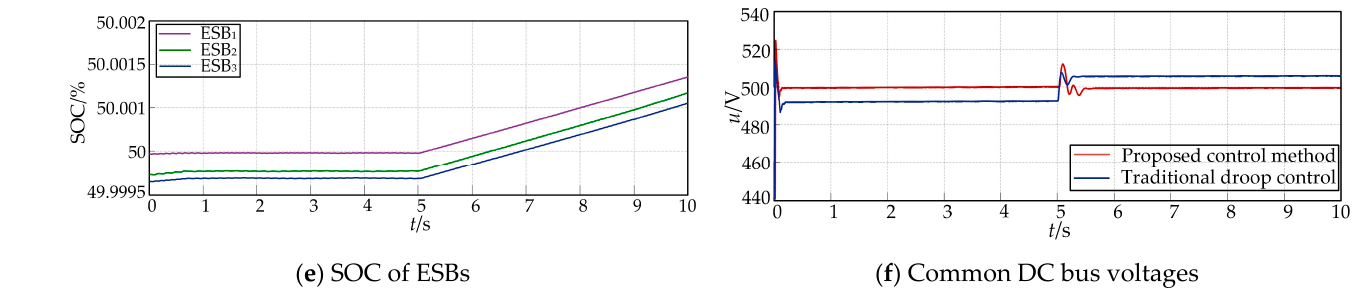
Figure 17. Simulation results in example 2.